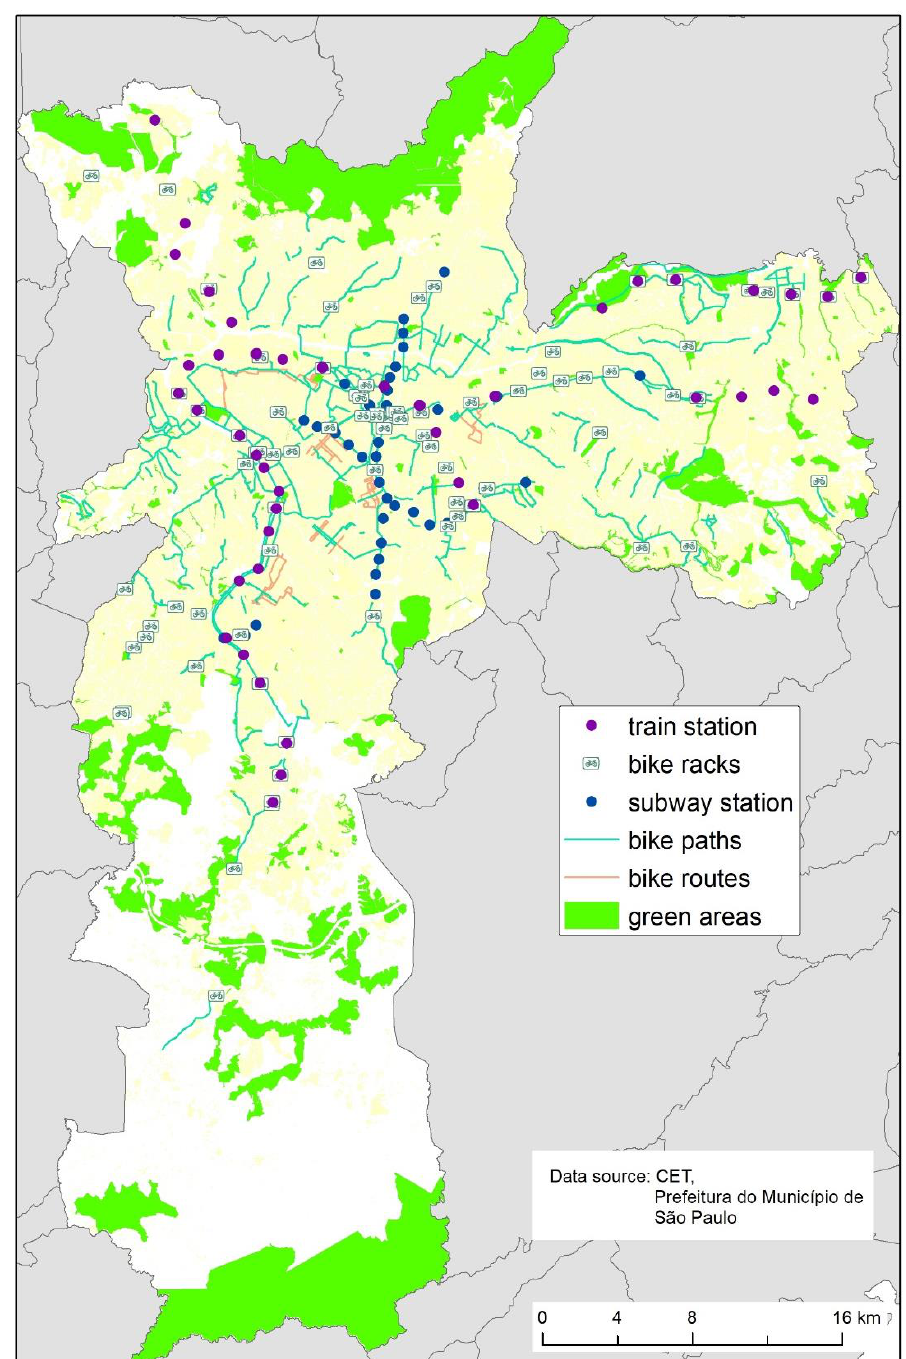
Figure 1. Map of bike paths, bike lanes, bike racks, train and subway stations in Sao Paulo, 2017.